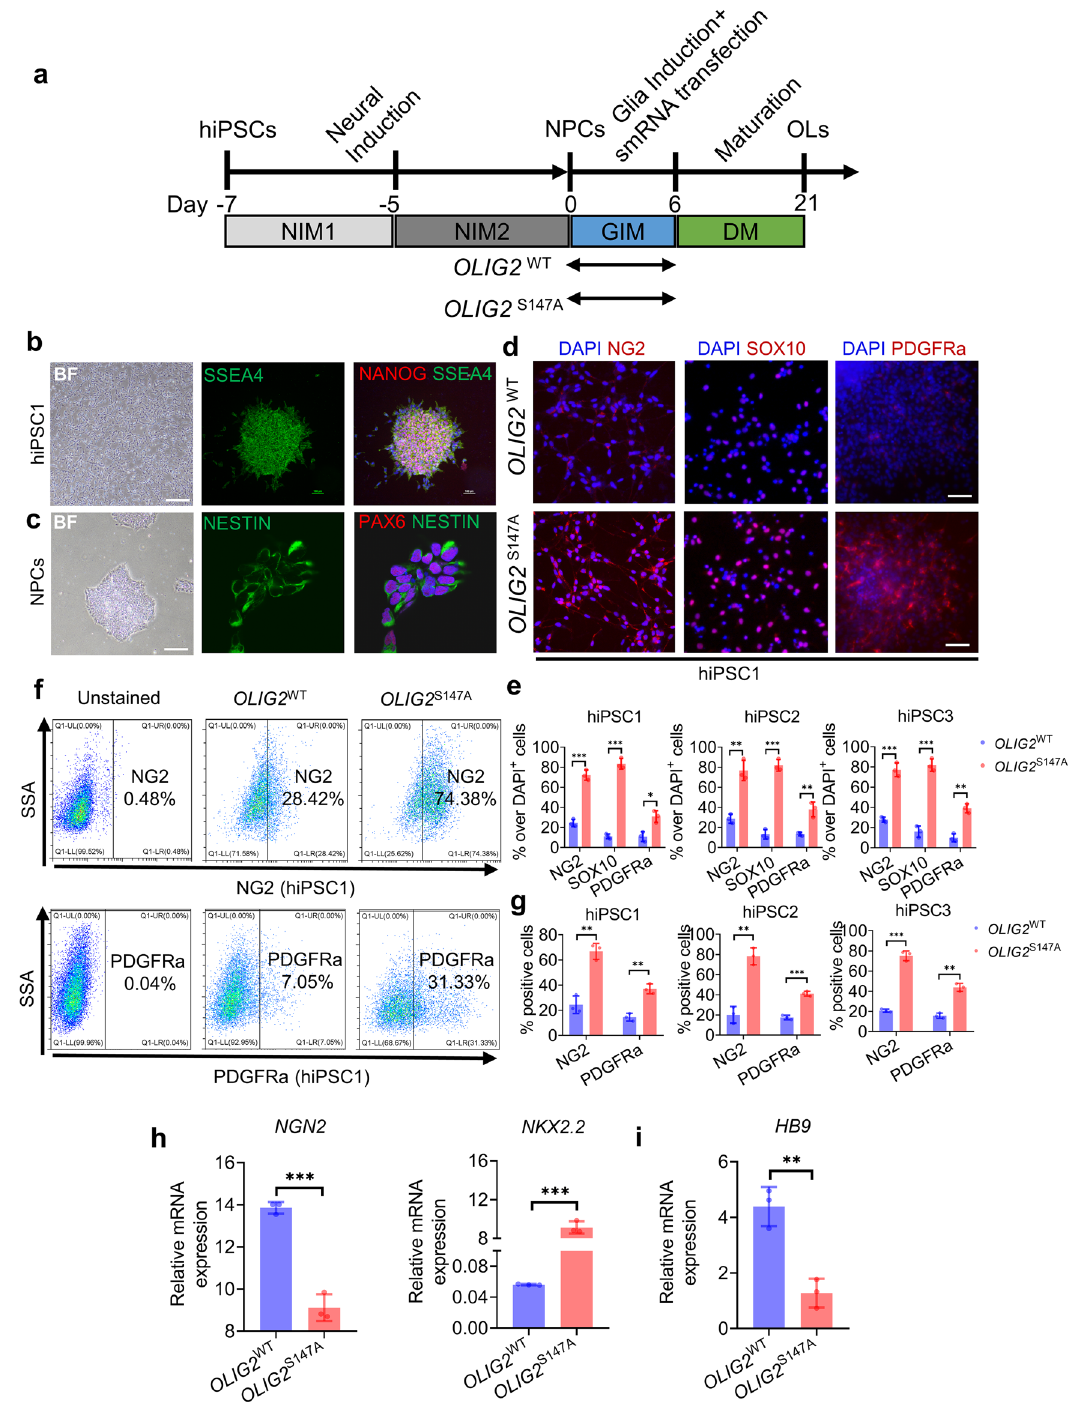
Fig. 2 A highly ef fi cient strategy for generating smRNA-induced oligodendroglial lineage cells from hiPSC-derived NPCs. a Diagram of the six daily smRNA differentiation protocols for hiPSCs. b Representative images of immuno fl uorescence staining for the human NANOG and SSEA4 proteins in cultured hiPSC1 cells (scale bar, 200 μ m). c Representative images of immuno fl uorescence staining for the human PAX6 and NESTIN proteins in hiPSC1- derived NPCs (scale bar, 20 μ m). d Representative images of immuno fl uorescence staining for NG2, SOX10, and PDGFR α in smRNA-transfected cells of the hiPSC1 line on day 6 (scale bar, 50 μ m). e Quanti fi cation of the percentage of NG2, SOX10 and PDGFR α on day 6 after smRNA transfection ( n = 3; * p < 0.05, ** p < 0.01, *** p < 0.001 using two-tailed Student ’ s t test). OLIG2 S147A mRNA induced greater NG2 + /SOX10 + /PDGFR α + OPC production than OLIG2 WT smRNA. f Representative fl ow cytometry analyses of the expression of NG2 and PDGFR α in smRNA-transfected cells of the hiPSC1 line on day 6. g Quanti fi cation of NG2 + and PDGFR α + cells among OLIG2 WT and OLIG2 S147A smRNA-transfected cells of the three different hiPSC lines on day 6 ( n = 3, ** p < 0.01, *** p < 0.001 using two-tailed Student ’ s t test). h The mRNA expression levels of a proneural marker gene ( NGN2 ) and oligodendroglial lineage marker gene ( NKX2.2 ) involved in OL differentiation on day 6 after smRNA transfection ( n = 3; *** p < 0.001 using two-tailed Student ’ s t test). i The mRNA expression levels of the MN-speci fi c marker gene HB9 on day 6 after smRNA transfection ( n = 3; ** p < 0.01 using two-tailed Student ’ s t test).